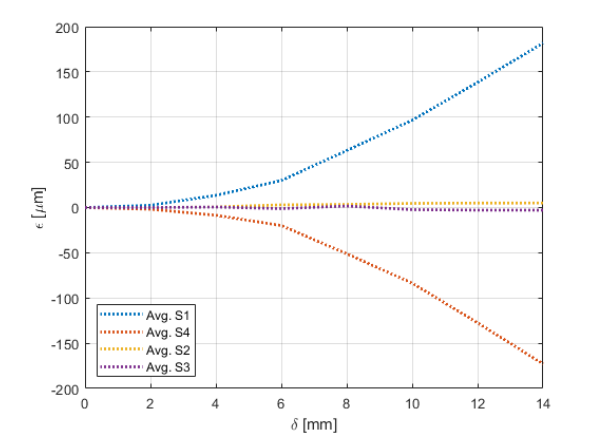
Figure 11. Strain trend in the top section of the wing undergoing twist with respect to deflection due to morphing.